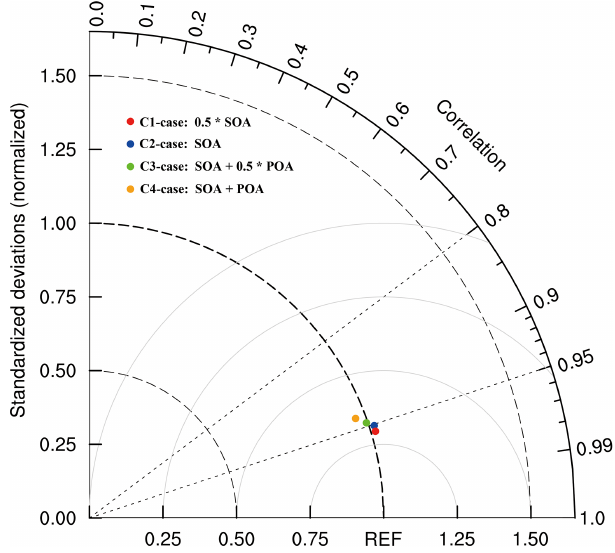
Figure 11. Taylor diagram (Taylor, 2001) to present the variance, bias, and correlation of the observed and simulated nitrate concen- trations at the CRAES site in Beijing from 10 to 27 February